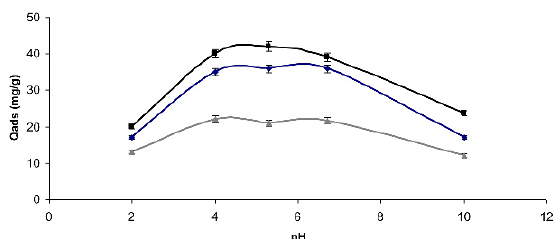
Figure 1. InfluenceofpHonphenoladsorptionoverHBEA( (cid:4) ),HFAU ( (cid:7) ) and HMOR ( (cid:78)